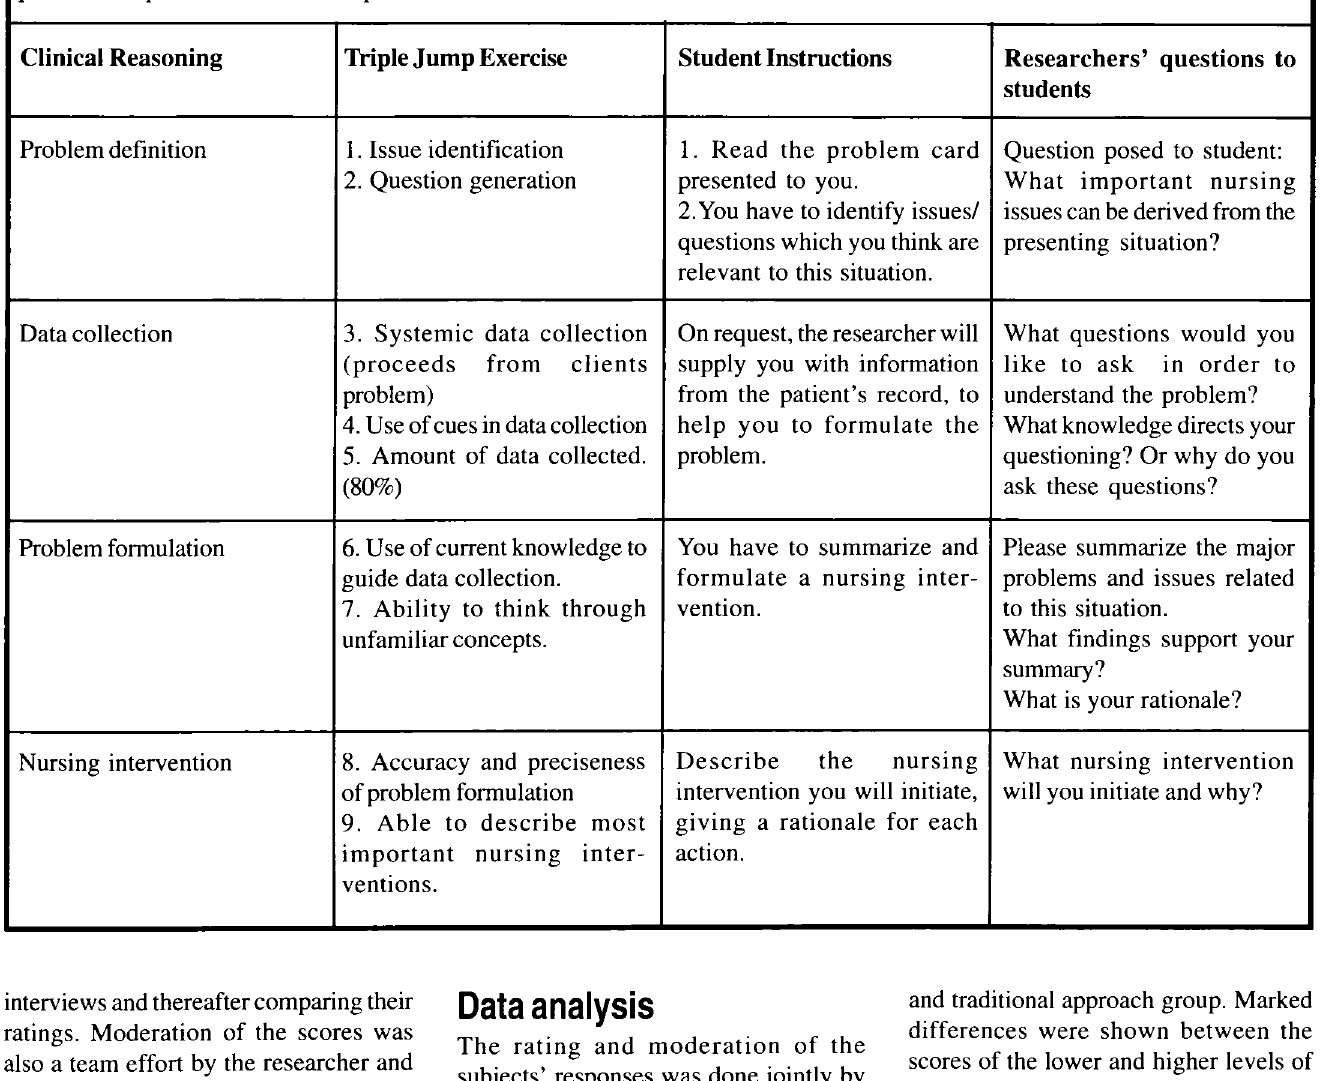
Table 2: Application of the conceptual framework during data collection using the Triple Jump Exercise